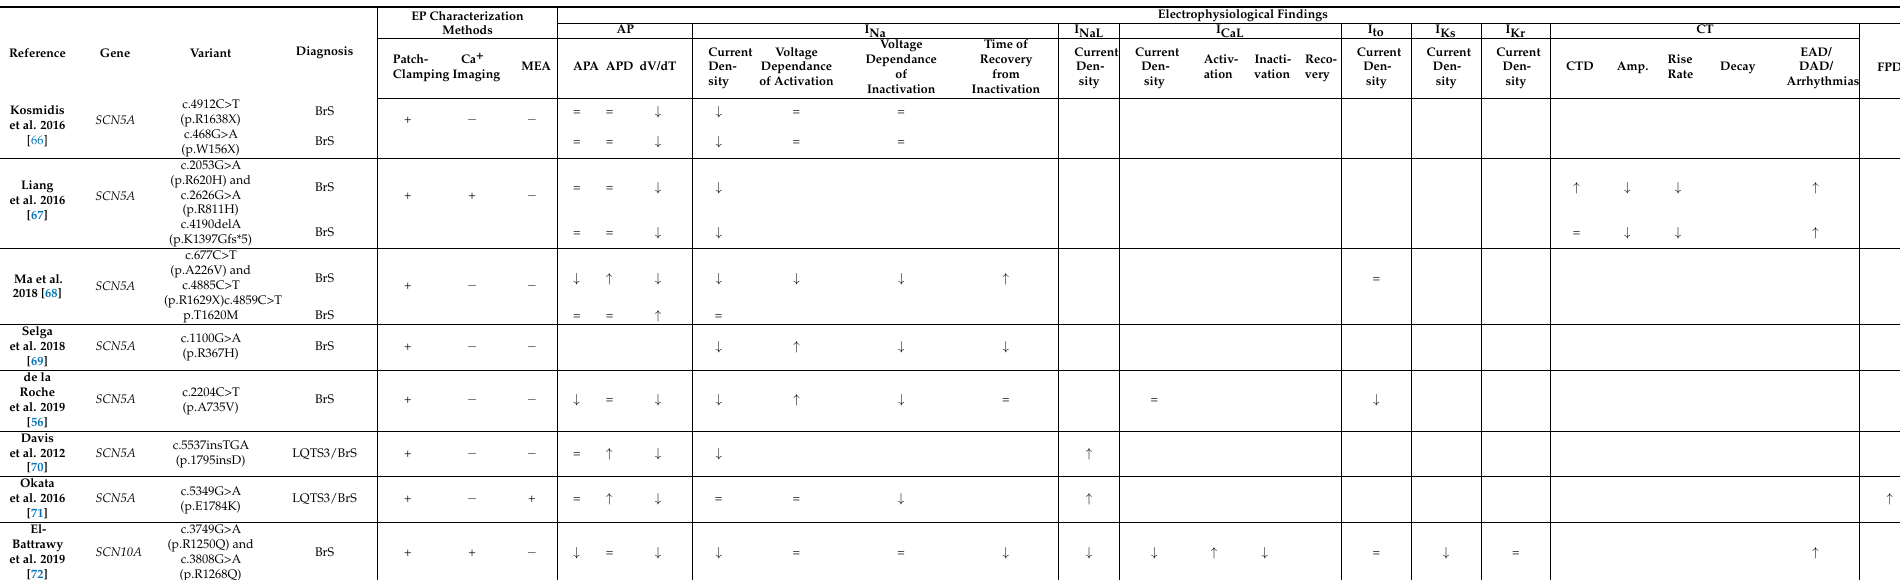
Table 1. Summary of the findings from published BrS iPSC-CM models. Table represents an overview of the identified gene variants, patient diagnosis, electrophysiological characterization methods used and obtained results. Data shown indicate the most important findings from investigated BrS iPSC-CMs models in comparison to control iPSC-CMs for action potential